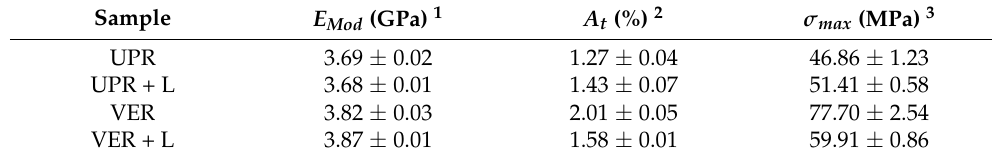
Table 5. Mechanical data for the UPR and VER composites with kraft lignin before